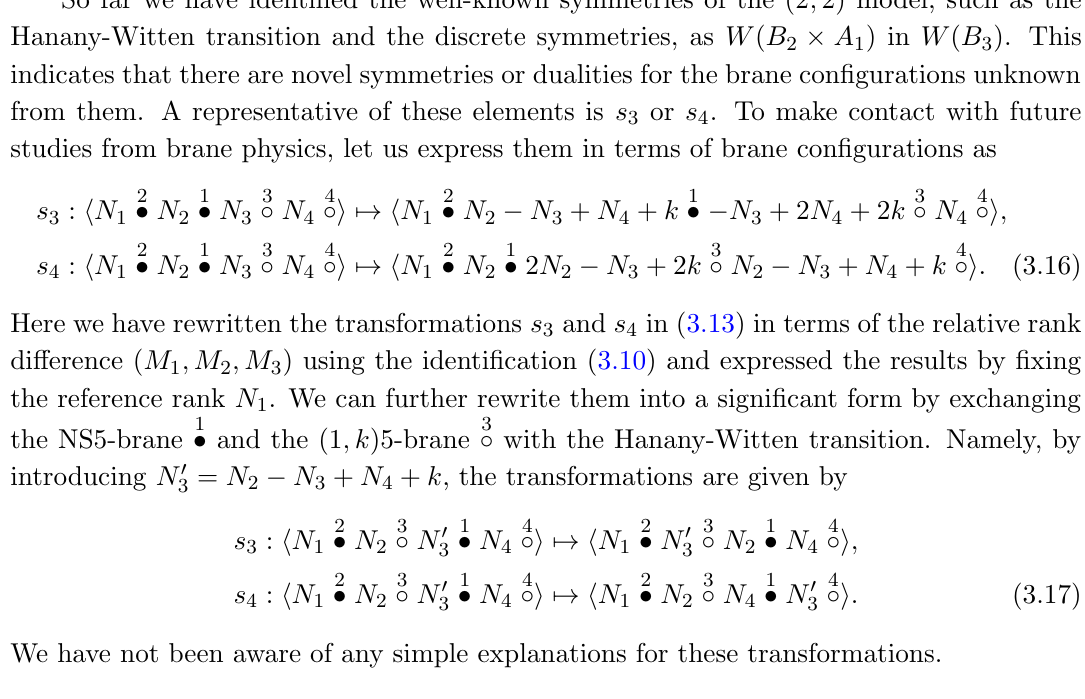
Figure 10 . Group-theoretical structure of the symmetries generated by the Hanany-Witten tran- sition and a few trivial symmetries such as the charge conjugation and the